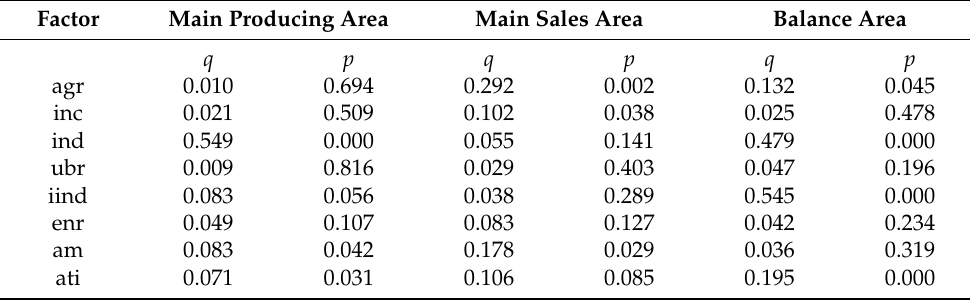
Table 5. Factor detection results of methane emission in different production